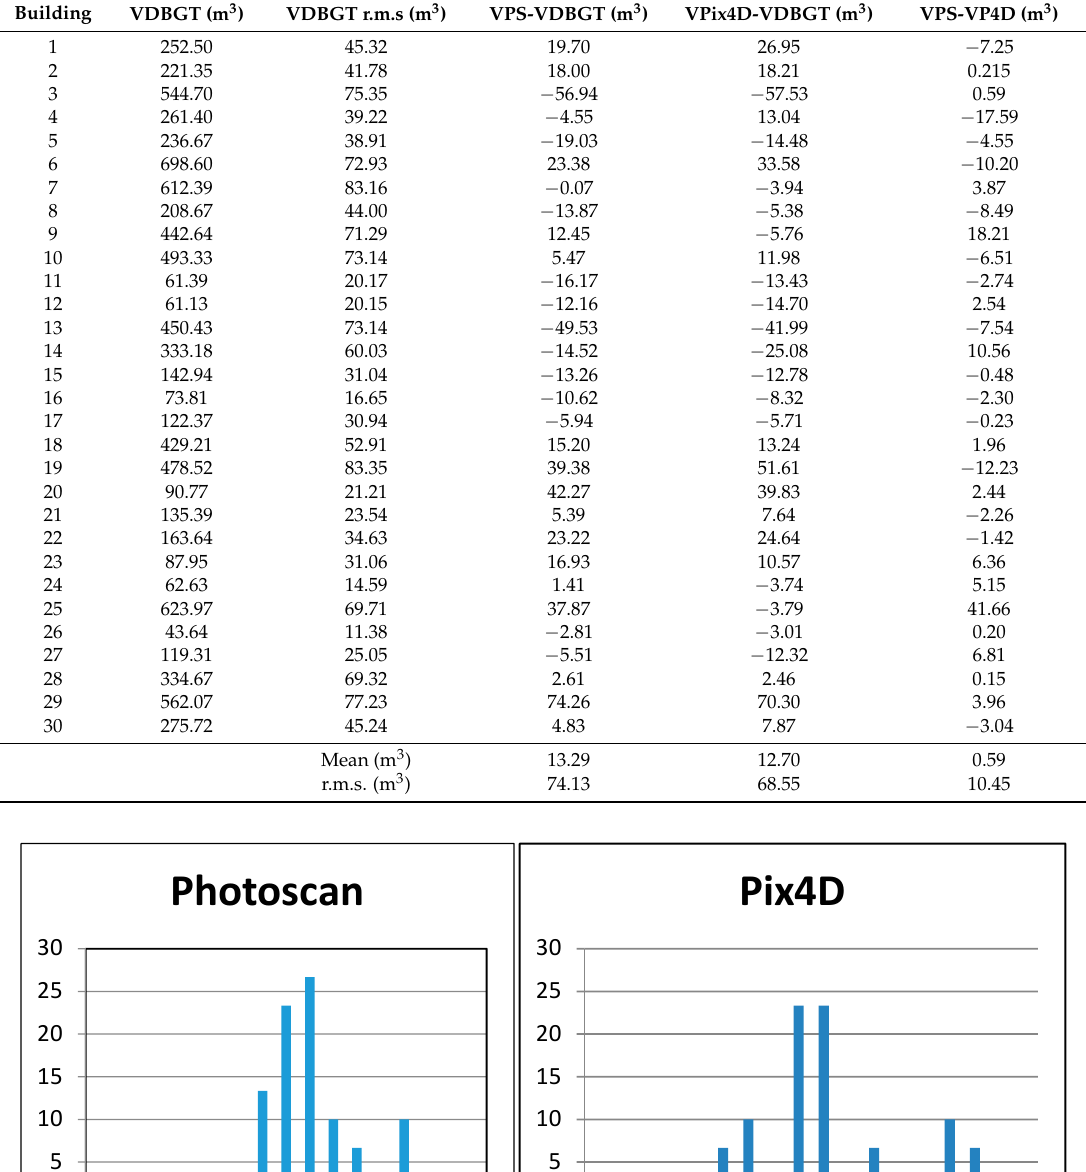
Table 6. Results of the area measurements.